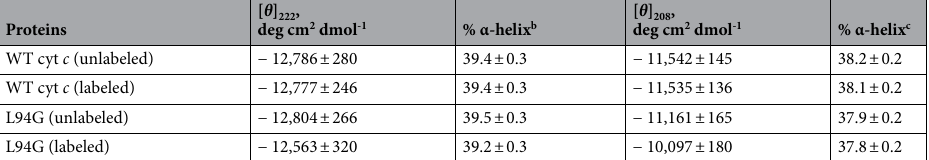
Table 1. α-helical content of WT cyt c and its L94G mutant a . a ± represents the error from the mean of errors of triplicate measurements. b α-helical content estimated using equation given by Morrisett et al. 36 . c α-helical content estimated using equation given by Greenfield & Fasman 37